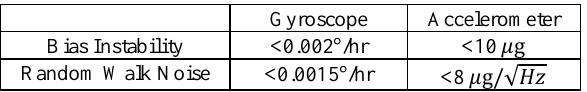
Figure 9. The result in OpenDRIVE Viewer.